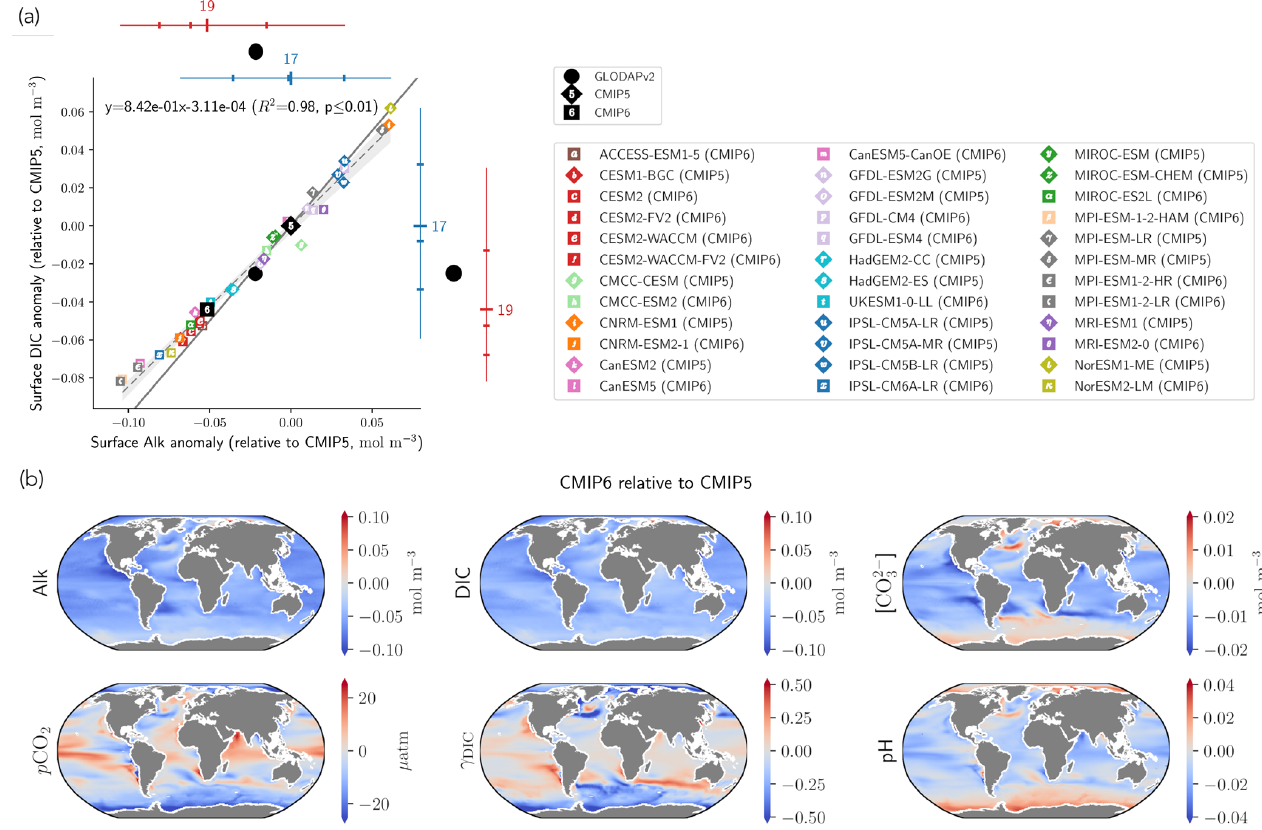
Figure 12. Surface open-ocean carbonate chemistry. (a) The relationship between mean surface-ocean Alk and DIC anomalies relative to the CMIP5 ensemble mean. The legend is the same as in Figs. 4 and 8, with the CMIP5 (CMIP6) ESMs represented with diamonds (squares). The CMIP5 (blue) and CMIP6 (red) ensemble range (line), mean (major tick) and quartiles (minor ticks) are given with the ensemble size, and GLODAPv2 observations are shown as black circles. The dashed line is the linear regression across all ESMs, and the solid line refers to the 1 : 1 anomaly line (points on this line have the same Alk–DIC as the CMIP5 ensemble mean and therefore effectively the same CO 2 − concentration). (b) Maps of the surface difference between the CMIP6 and CMIP5 ensemble means for carbonate system